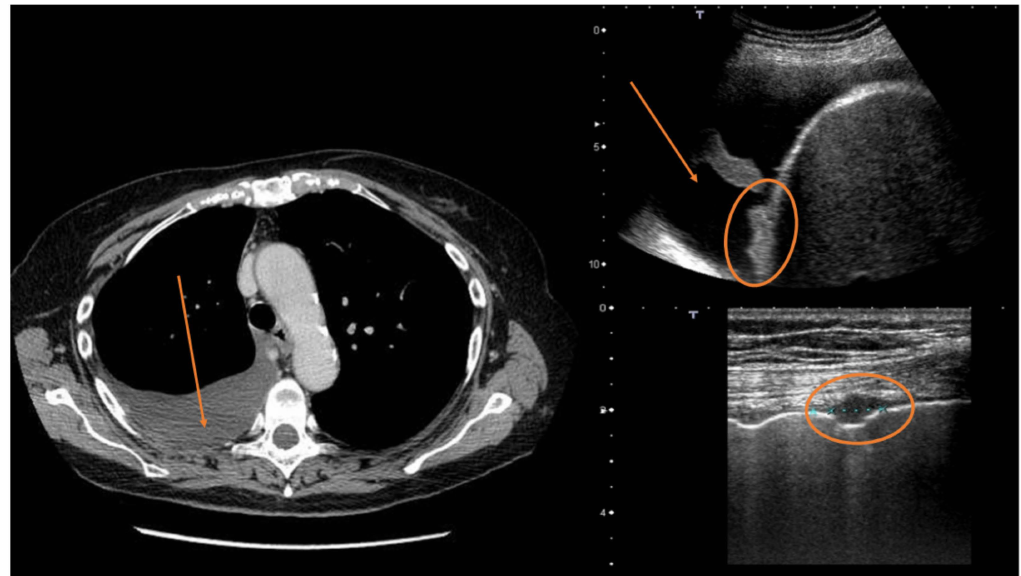
Figure 6. Ultrasound scans of a patient with mesothelioma. On the left, the CT scan shows only pleural effusion (red arrow). The upper right ultrasound scan clearly shows the pleural effusion (red arrow) and diaphragmatic nodulations (red circle). The lower right ultrasound scan shows a parietal pleural nodule (red